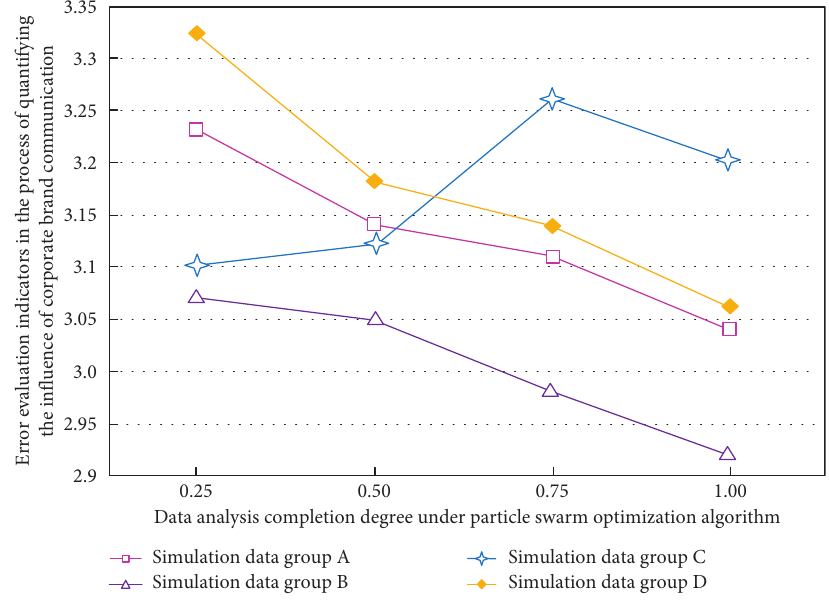
Figure 6: Simulation analysis of the influence error of PSO algorithm on corporate brand communication under different data analysis completion